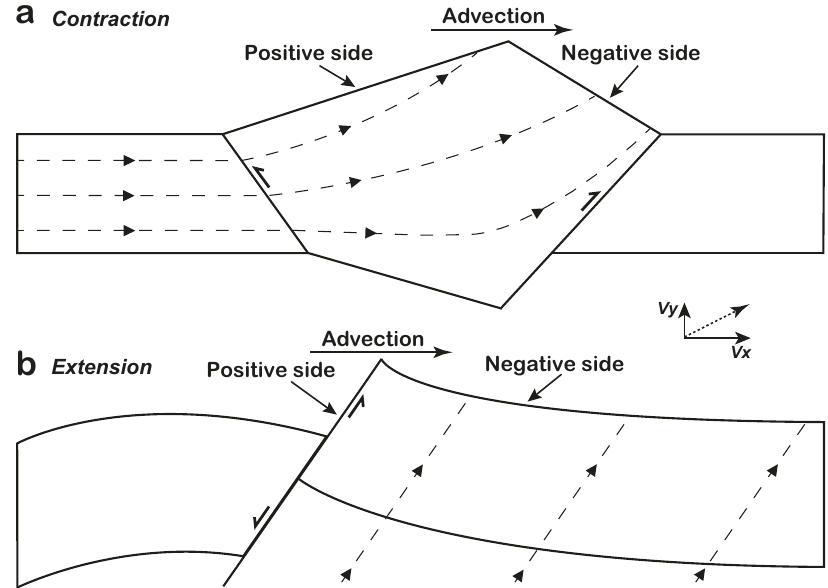
Fig. 1 Kinematic models for tectonic uplift and horizontal advection. Material transport (marked as dashed lines with arrows), with vertical component (Vx) and horizontal component (Vy), causes tectonic uplift and horizontal advection in convergent orogen a (modi fi ed after refs. 6, 34 ) and extensional orogen b . For each system, advection is from the positive side to the negative side. For the positive side, due to advection, the range half-width tends to increase. By contrast, the range half-width of the negative side tends to